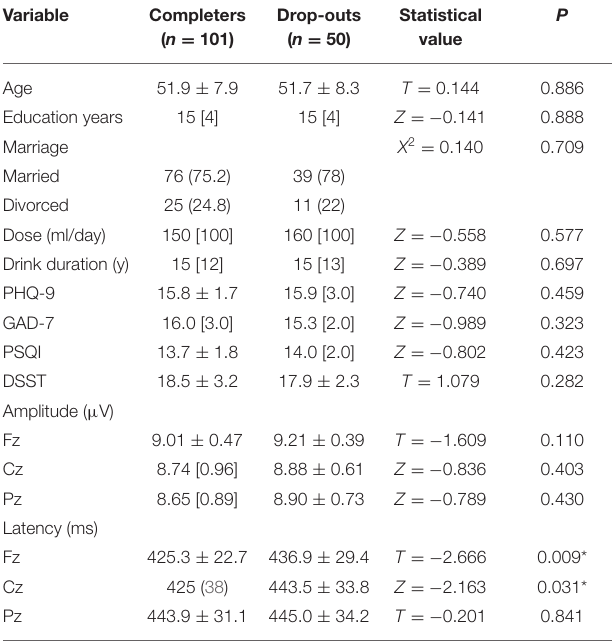
TABLE 4 | Comparison of completers and dropouts of AUD